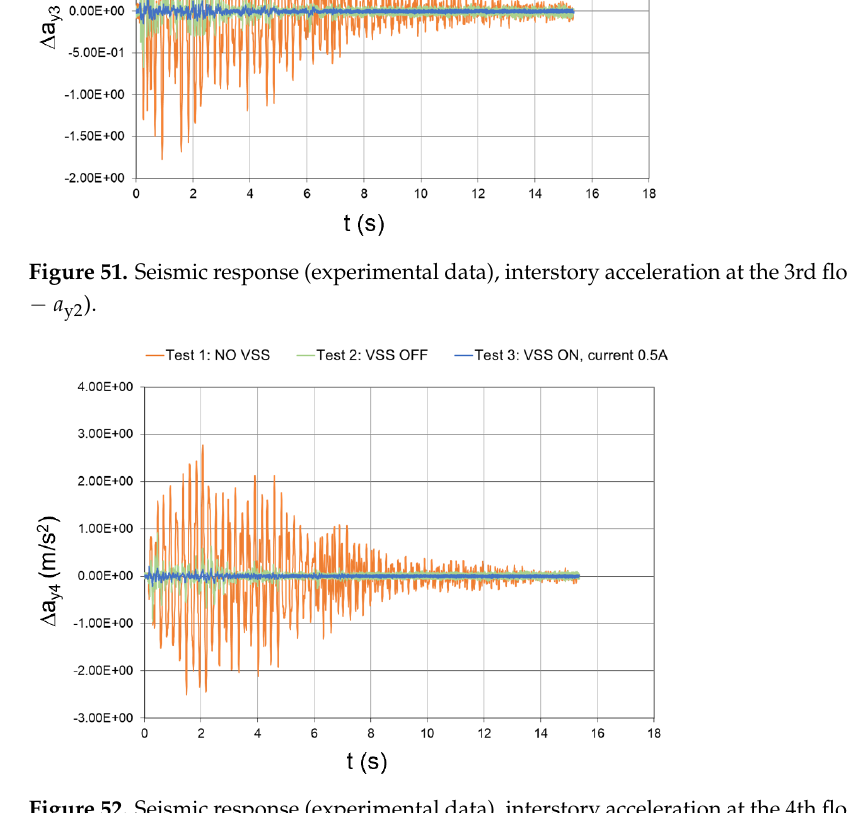
Figure 52. Seismic response (experimental data), interstory acceleration at the 4th floor ( Δ 𝑎 y4 = 𝑎 y4 𝑎 y2 − 𝑎 y3 ).